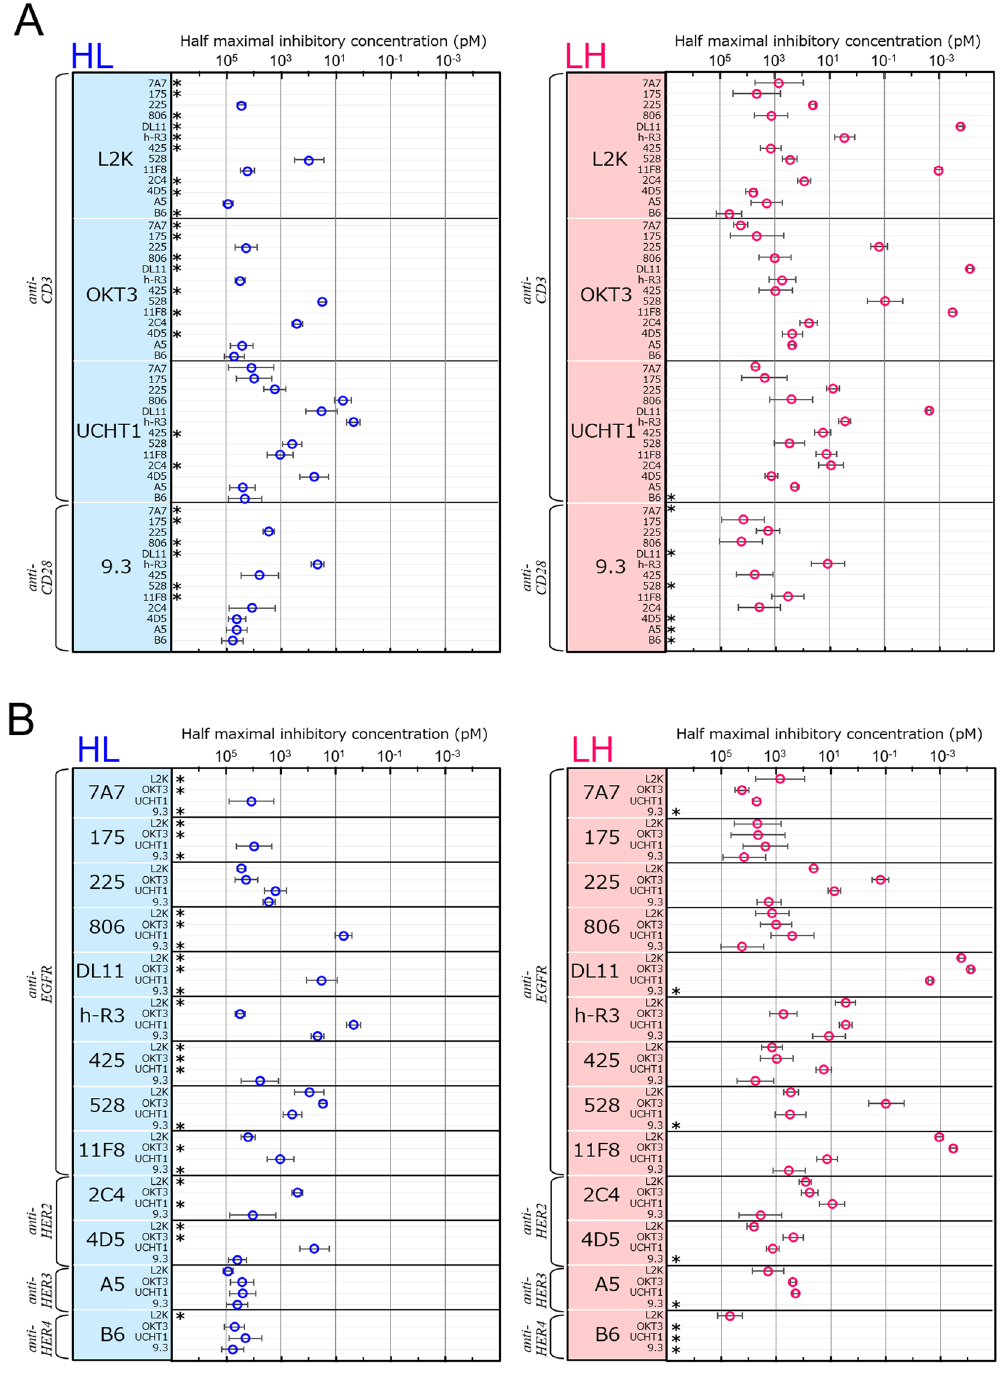
Figure 4. IC 50 mapping of the entire diabody library to extract several rules for cytotoxicity IC 50 values of the diabodies were grouped in terms of ( A ) the anti-T-lymphocyte Fv (i.e., anti-CD3 or -CD28 Fv), and ( B ) the anti-cancer Fv (i.e., anti-EGFR family Fv) used to construct the diabody. IC 50 values were calculated from sigmoidal dose-response curve model, using PRISM software, and error bars represent 95% confidence intervals. Asterisks represent the diabodies with the cytotoxicity of less than 50% at 100 nM, because IC 50 cannot be